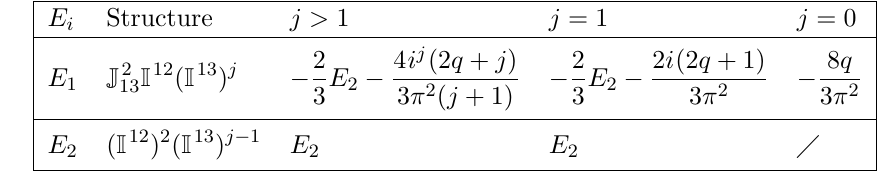
Table 8 . Ward identities of the supersymmetry current for the correlator spin (0 ; 1 ( j + 1)). 2